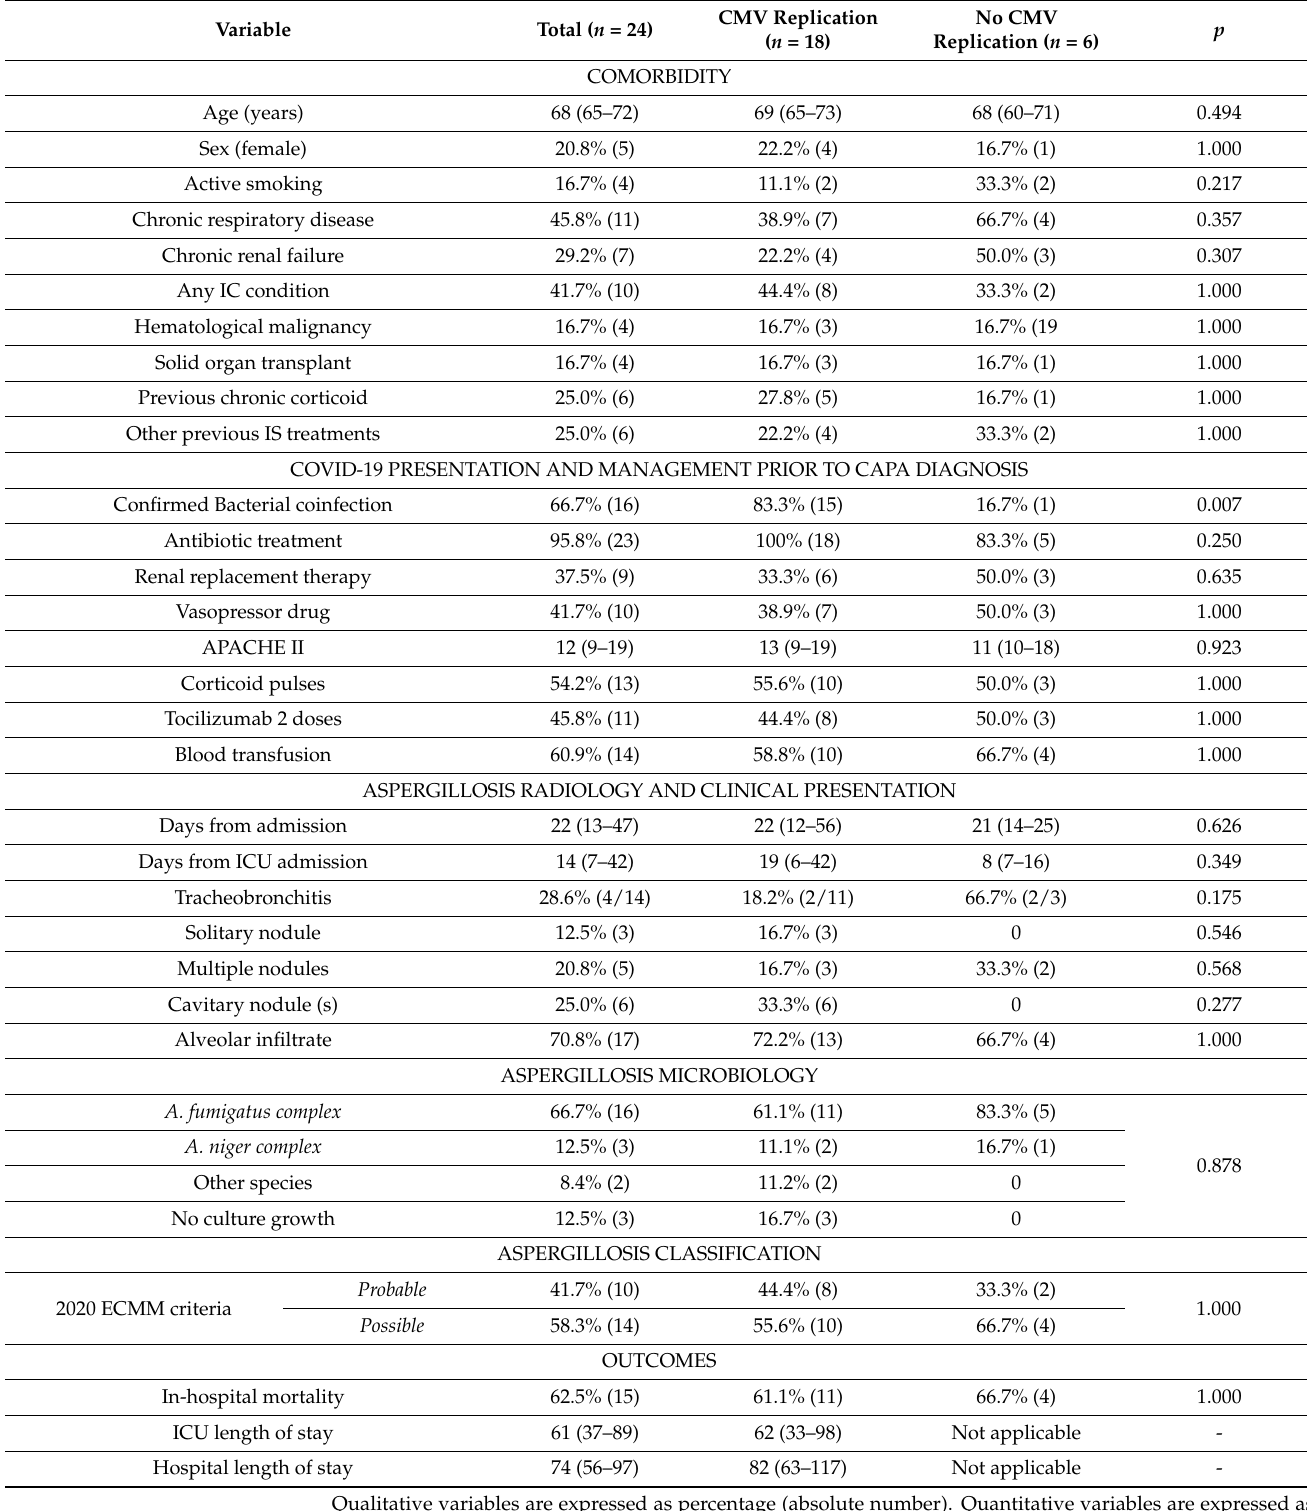
Table 3. CMV replication-associated factors among CAPA patients with serum CMV-DNA